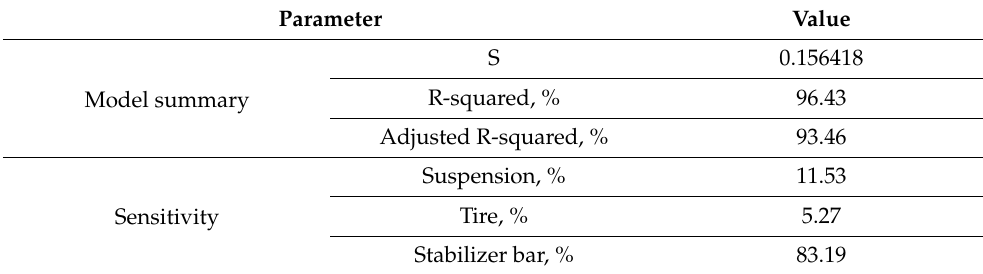
Table 7. Suspension and tire test results with stabilizer bar (double-lane change; roll angle).